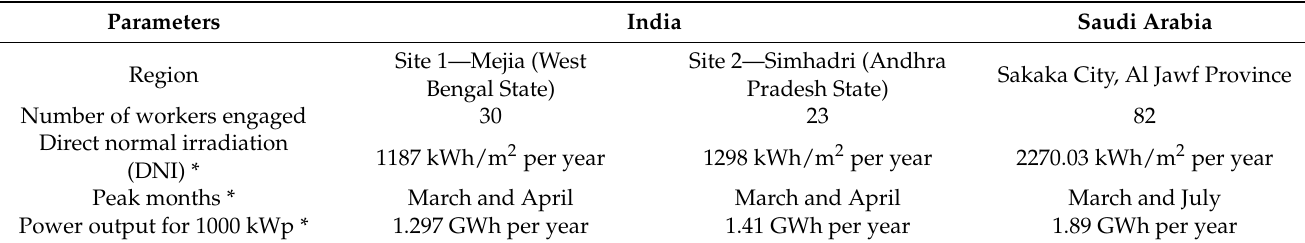
Table 1. Overview of the locations considered for this study.